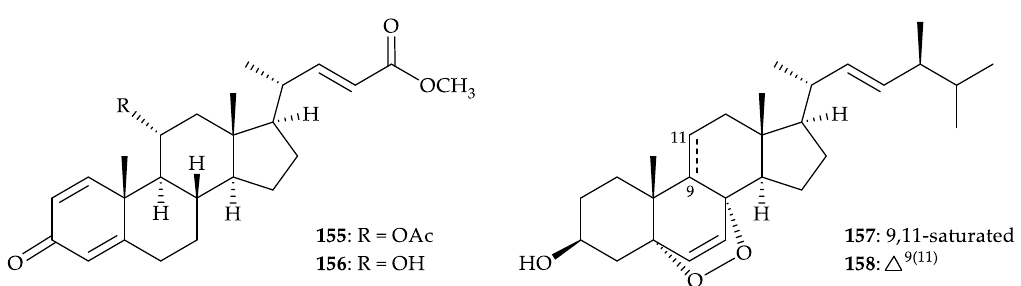
Figure 25. Structures of dendronesterones D ( 155 ) and E ( 156 ), 5α,8α-epidioxy-24( S )-methyl- cholesta- Figure 25. 6,22-dien-3β-ol ( 157 ), and 5α,8α-epidioxy-24( S )-methylcholesta-6,9,22-trien-3β-ol ( 158 ). Two new 2,5-piperazinedione derivatives, janthinolides A ( 159 ) and B ( 160 ), as well as a new